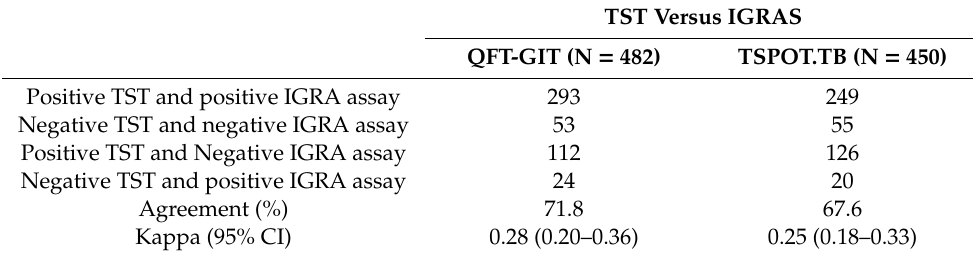
Table 3. Agreement and discordance between TST and IGRA